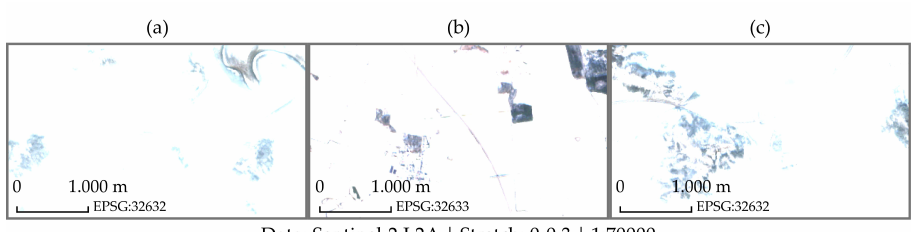
Figure 19. Subsets of acquisitions with snow cover in February 2018: ( a ) Röstebachtalbrücke 14